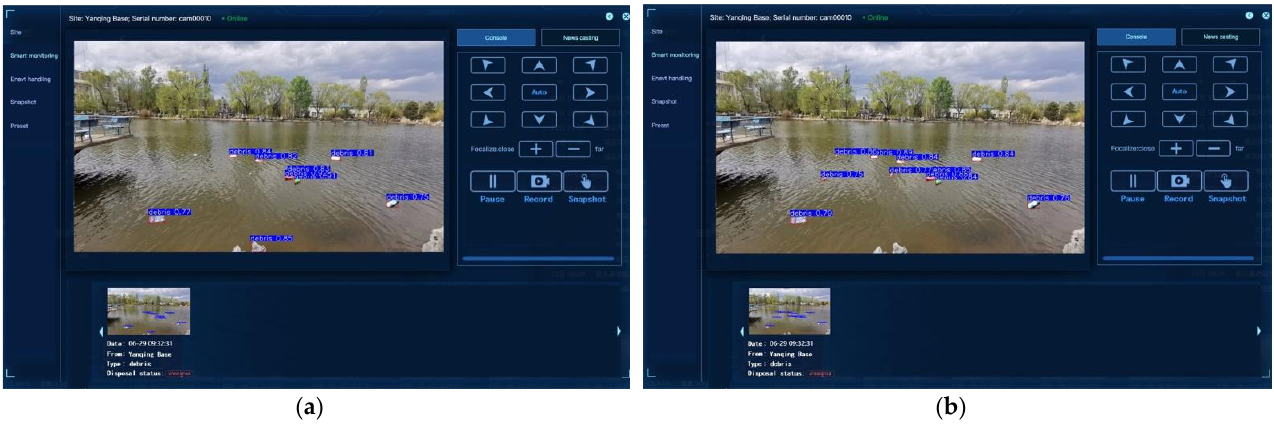
Figure 9. Floating debris detection function of intelligent river patrol system. ( a ) The effect of YOLOv5s real-time detection; ( b ) the effect of YOLOv5-CB real-time detection.